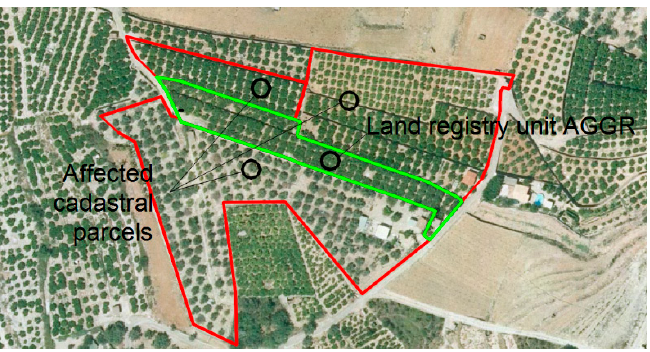
Figure 2. Bounded land registry unit and affected cadastral parcels. Source: own elaboration.